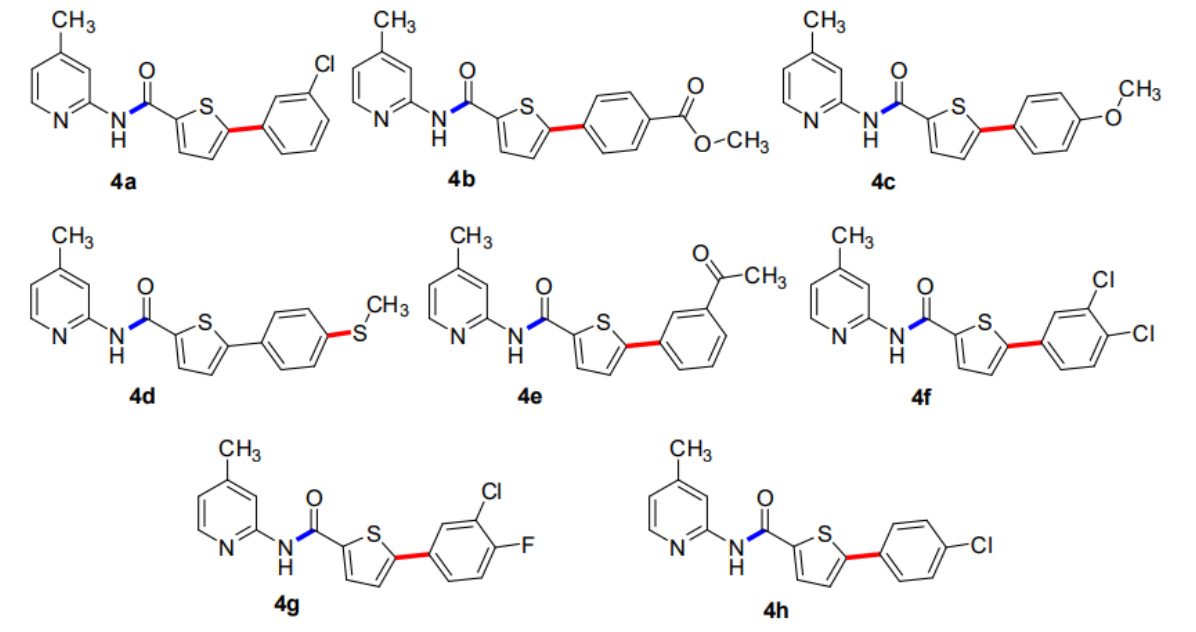
Figure 1. An overview of 5-aryl- N -(4-methylpyridin-2-yl)thiophene-2-carboxamide analogues ( 4a–h ).